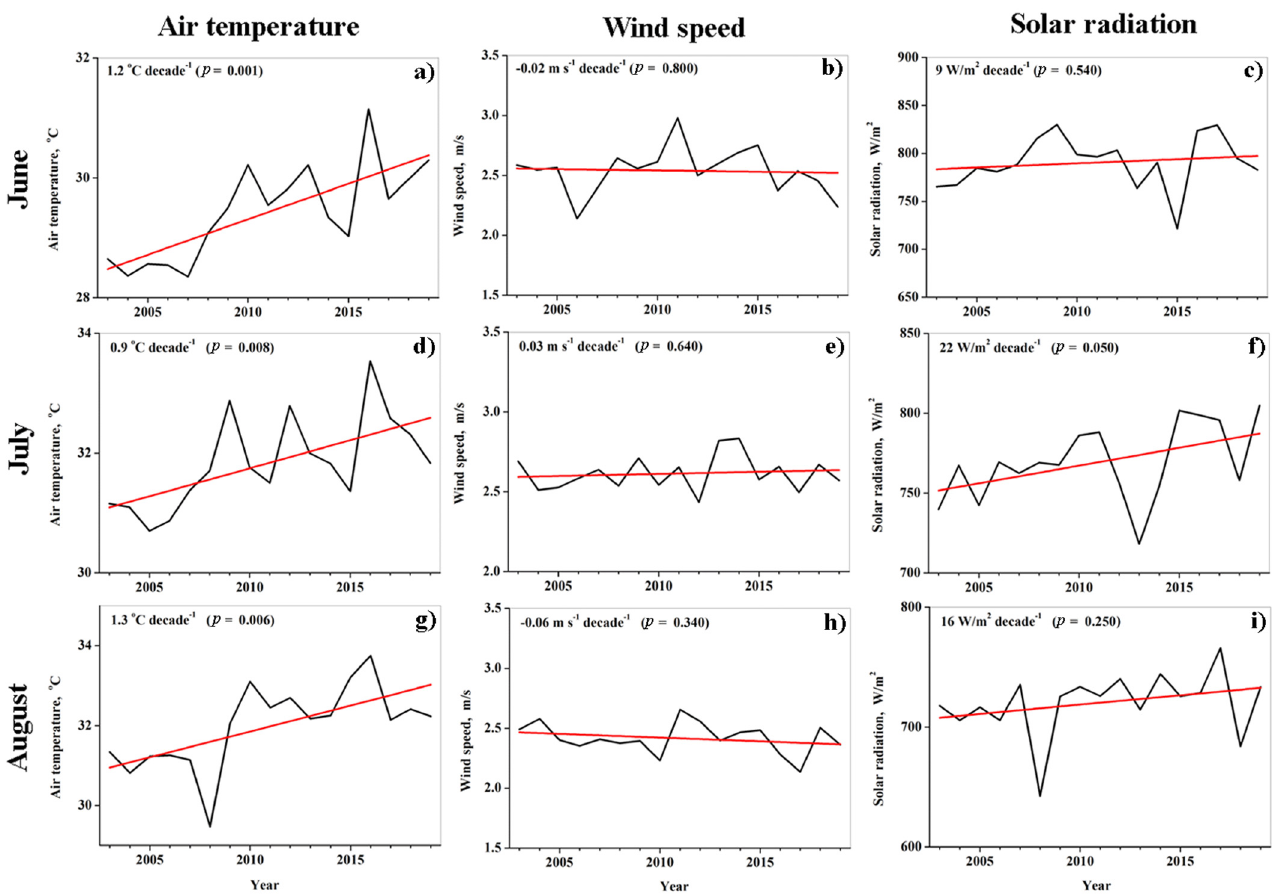
Figure 10. Year-to-year variations of ( left column ) ( a , d , g ) air temperature, ( middle column ) ( b , e , h ) wind speed, and ( right column ) ( c , f , i ) solar radiation measured at the Zemah meteorological station, between 9 LT and 10 LT, in the summer months. The top panel ( a – c ) corresponds to June; the middle panel ( d – f ) corresponds to July, and the bottom panel ( g , h , i ) corresponds to August. The straight red lines designate linear fits.